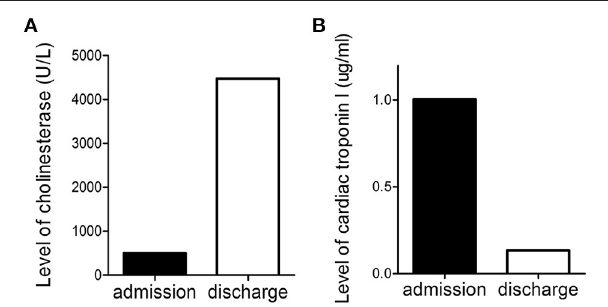
FIGURE 3 | Level of cholinesterase (A) and cardiac troponin I (B) before admission and at